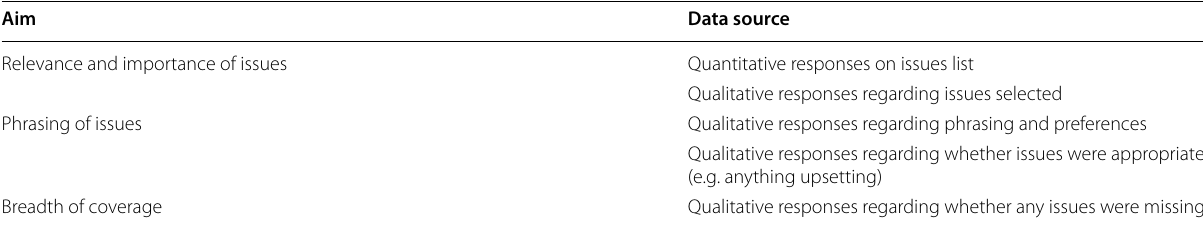
Table 2 Aims of discussions with PwPSC and clinicians, and data sources for assessing each aim